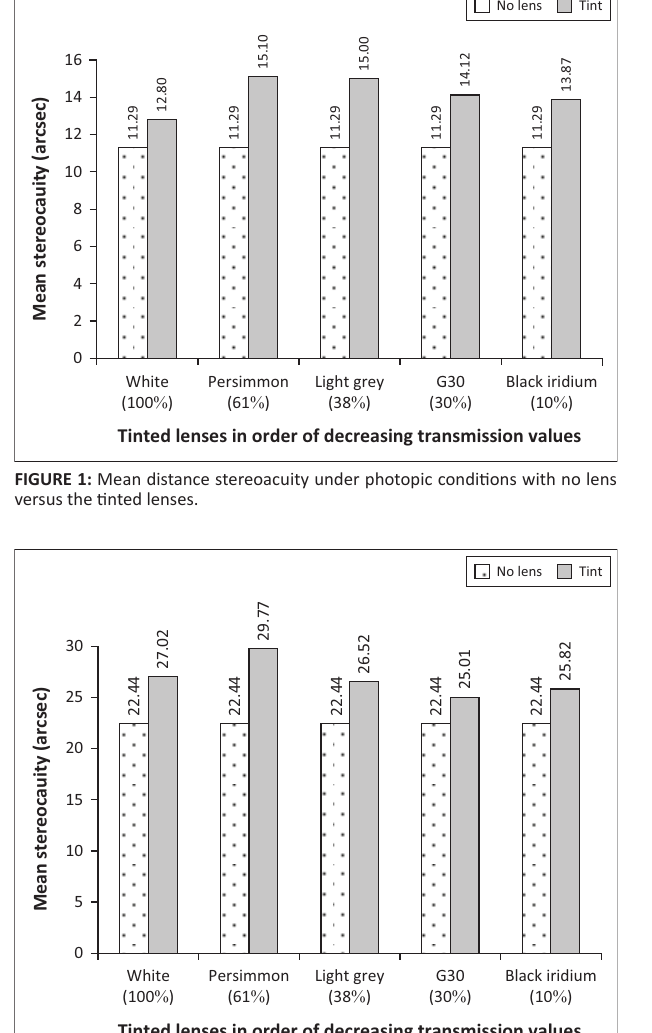
FIGURE 2: Mean distance stereoacuity under mesopic conditions with no lens versus the tinted lenses.